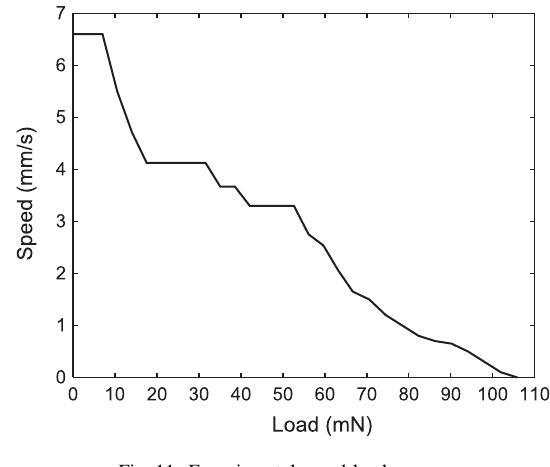
Fig. 11. Experimental speed-load curve.